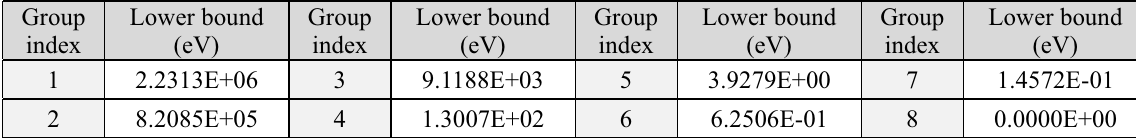
Table 1. Eight energy groups structure used for the generation of pin cell homogenized cross sections.